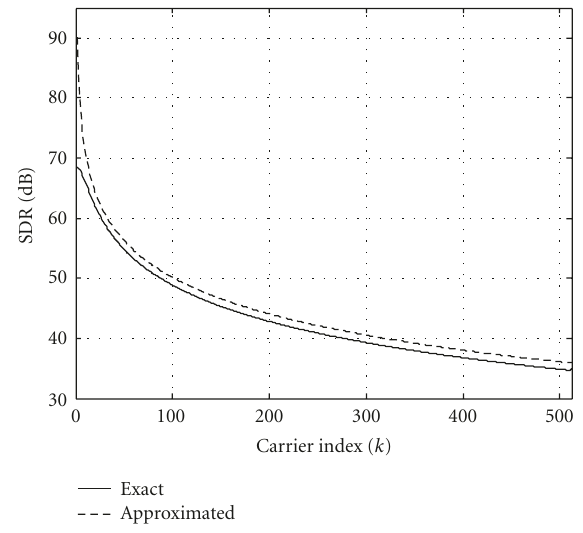
Figure 5: SDR values computed by taking into account the ICI and the desired symbol attenuation (exact) or only the phase shift (ap-